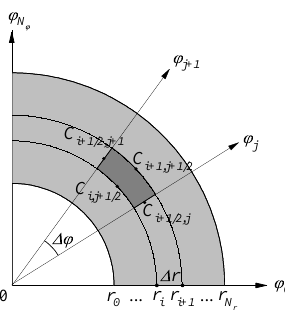
Figure 2. Schematic representation of the mesh for computations in the layer Ω 2